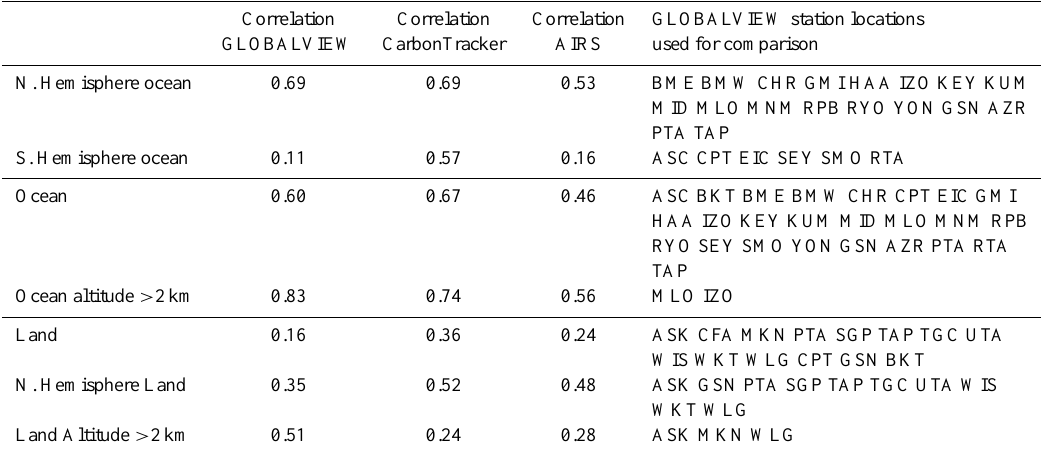
Table 3. TES correlation to GLOBALVIEW, CarbonTracker, and AIRS for different